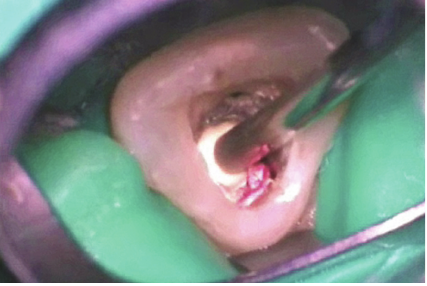
Figure 4: Filling with MTA after enclosing the canal path with gutta-percha.